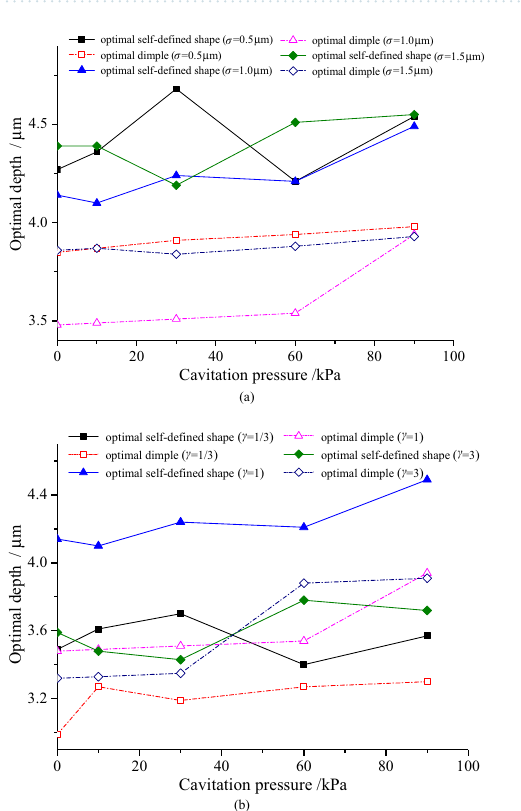
Figure 15. Variation of the optimal depth with sliding velocity.